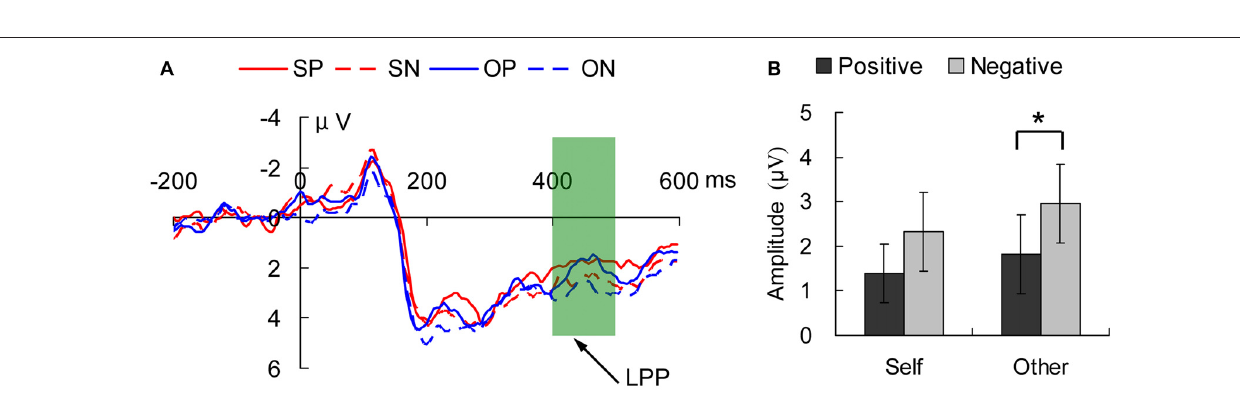
FIGURE 4 | The three-way interaction in the late positive potential (LPP; 400–500 ms) component in the anterior brain. (A) Displays the waveforms in the four conditions and (B) shows the average amplitudes in the LPP time-window. The solid lines show the positive emotion and the dashed lines show the negative emotion. self positive (SP), self negative (SN), other positive (OP), other negative (ON) indicate the conditions of self-referential positive emotion, self-referential negative emotion, other-referential positive emotion and other-referential negative emotion, respectively. The error bars are the standard errors in each condition. ∗ p <